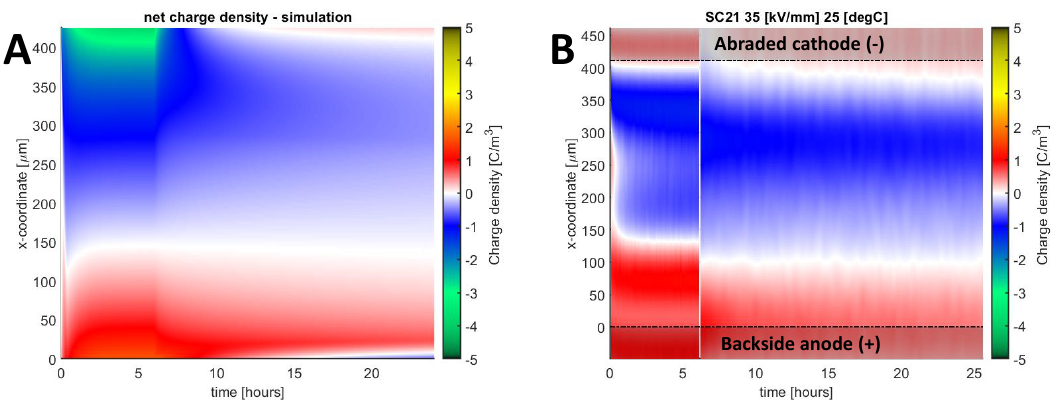
Figure 10. Colormap of net charge density obtained in simulation ( A ) and in measurement ( B ) for sample SC-21 subjected to −15 kV biasing voltage at 25 °C.